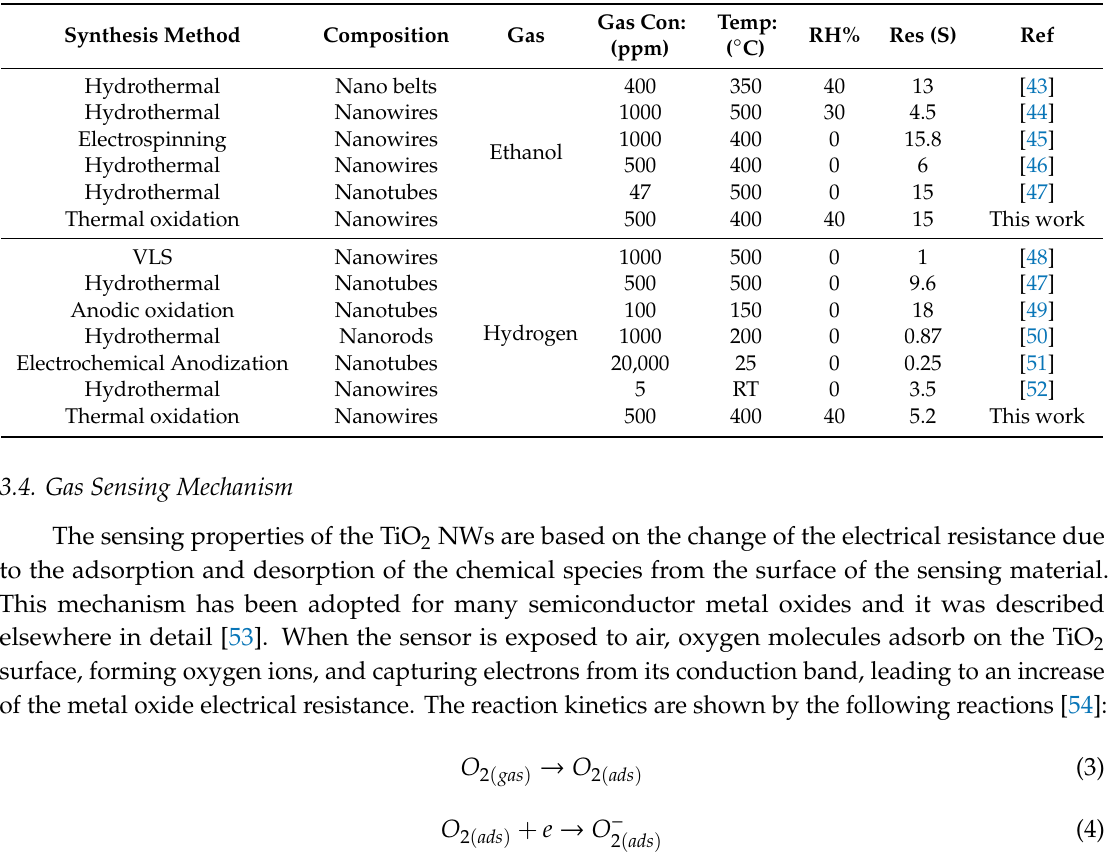
Table 3. Summary of H 2 and ethanol sensing performances of TiO 2